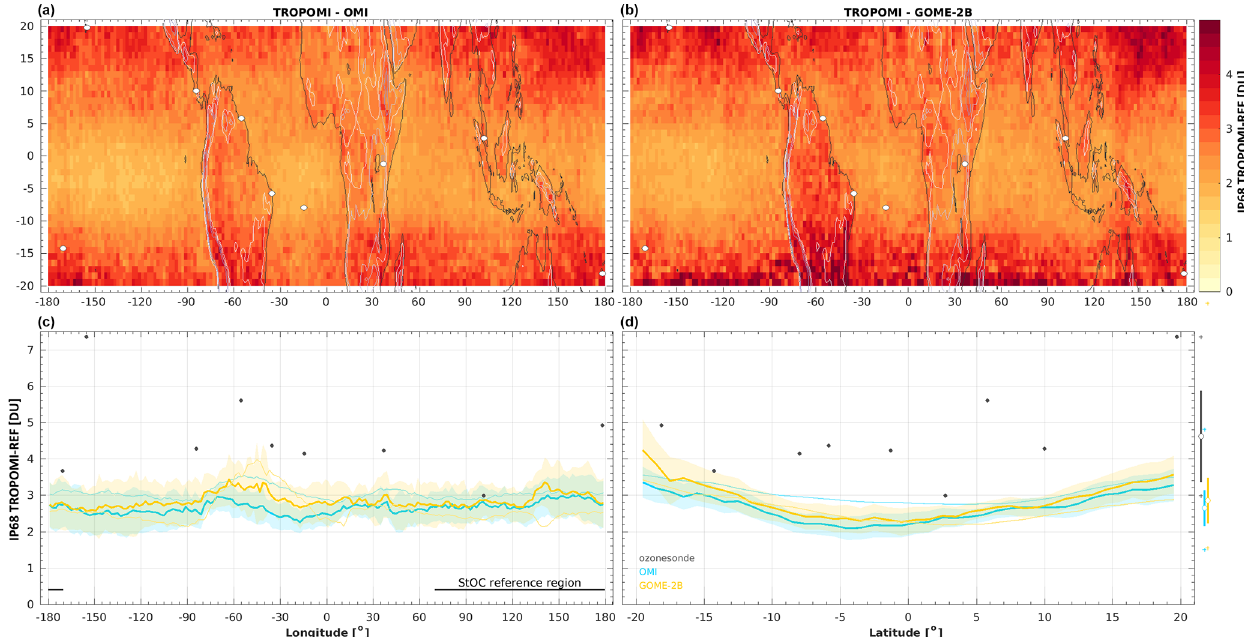
Figure 7. Like Fig. 5 but for the 68% interpercentile of the differences (dispersion). (c, d) Thin lines show combined ex ante uncertainty (1 σ ) for the satellite intercomparison. (d) Mean and standard deviation (1 σ ) of the dispersion estimates over the ground-based network (sonde) or tropical belt (satellite) are displayed outside the axis, together with minimum and maximum values (plus